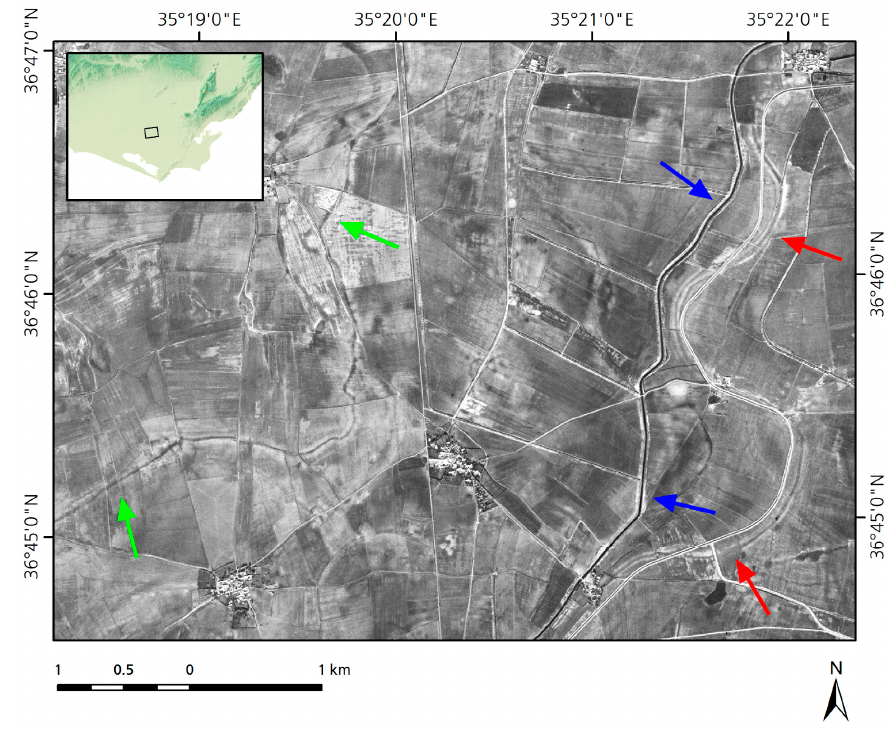
Figure 11. Detail of a CORONA scene (DS1105-2267, DA003, 20.11.1968). The course of the large palaeochannel visible on the DEM is marked with red arrows. A modern canal is following its course. The blue arrows points to a recent canal from the 1960s. The green arrow point to a relict canal © Susanne Rutishauser.